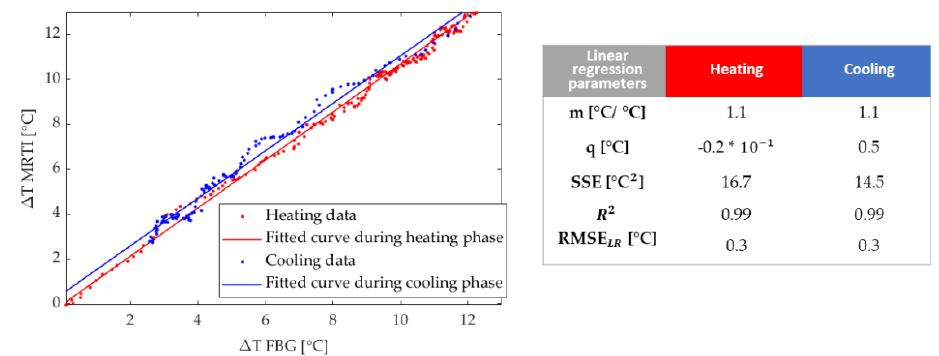
Figure 9. Linear regressions and their parameters for heating (red) and cooling (blue) phases for the Test 1. Fitted curves are plotted together with the data collected during the overall procedure.